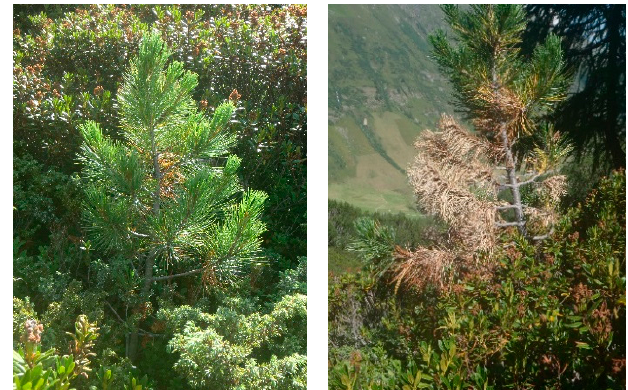
Figure 4. Branches of P. cembra in a hollow with long-lasting snow cover, where Rhododendron ferrugineum L. is the dominating shrub ( left ). Predominantly dead lower branches caused by snow mold. Note shoot tips with undamaged green needles ( right ).